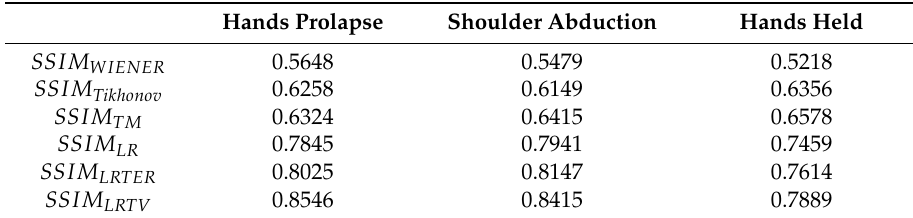
Table 4. Structural similarity (SSIM) with different algorithms in